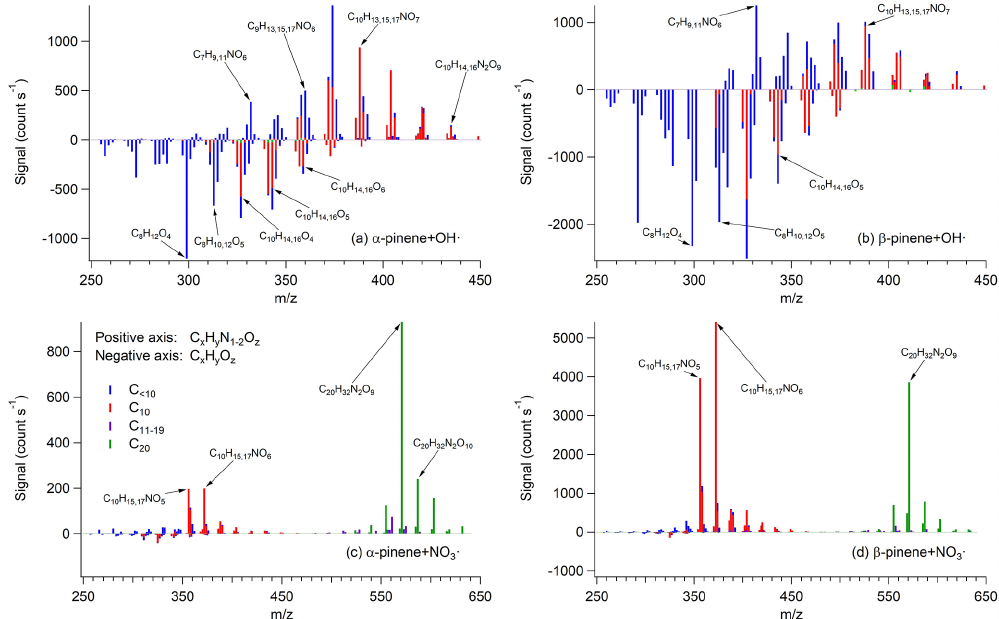
(cid:113) (cid:113) from Exp. 3, (b) β -pinene + OH from Exp. 6, (c) α - (cid:113) from Exp. 14. Top portion of each panel represents C x H y N 1 − 2 O z , whereas bottom